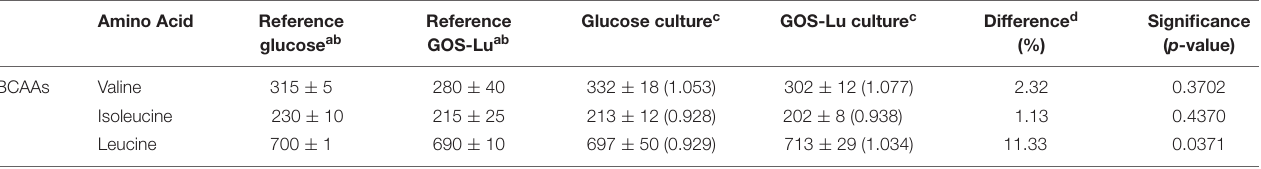
TABLE 4 | Quantification of extracellular BCAAs after GOS-Lu fermentation. Amino Acid